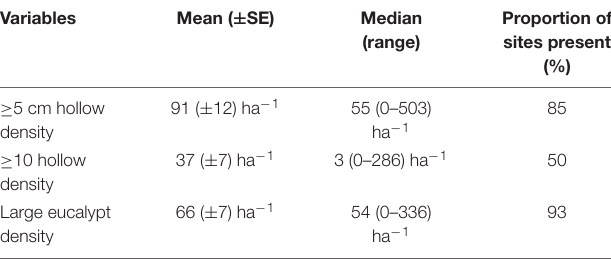
TABLE 3 | The density of hollows and large eucalypts across the 82 sites surveyed on Melville Island.